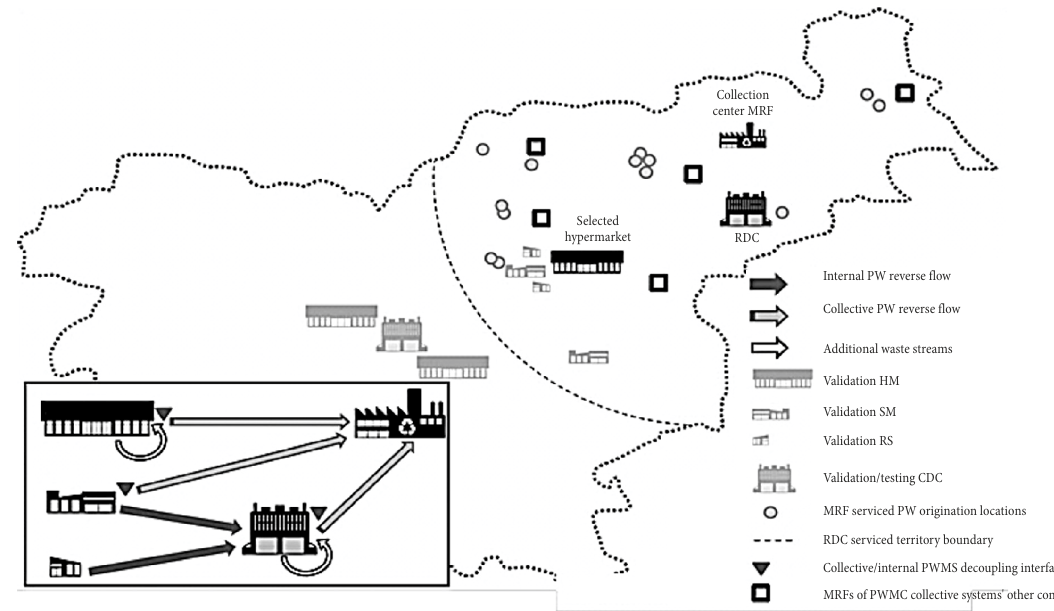
Figure 2. Examined PWM network subsystem and its accompanying RL channel